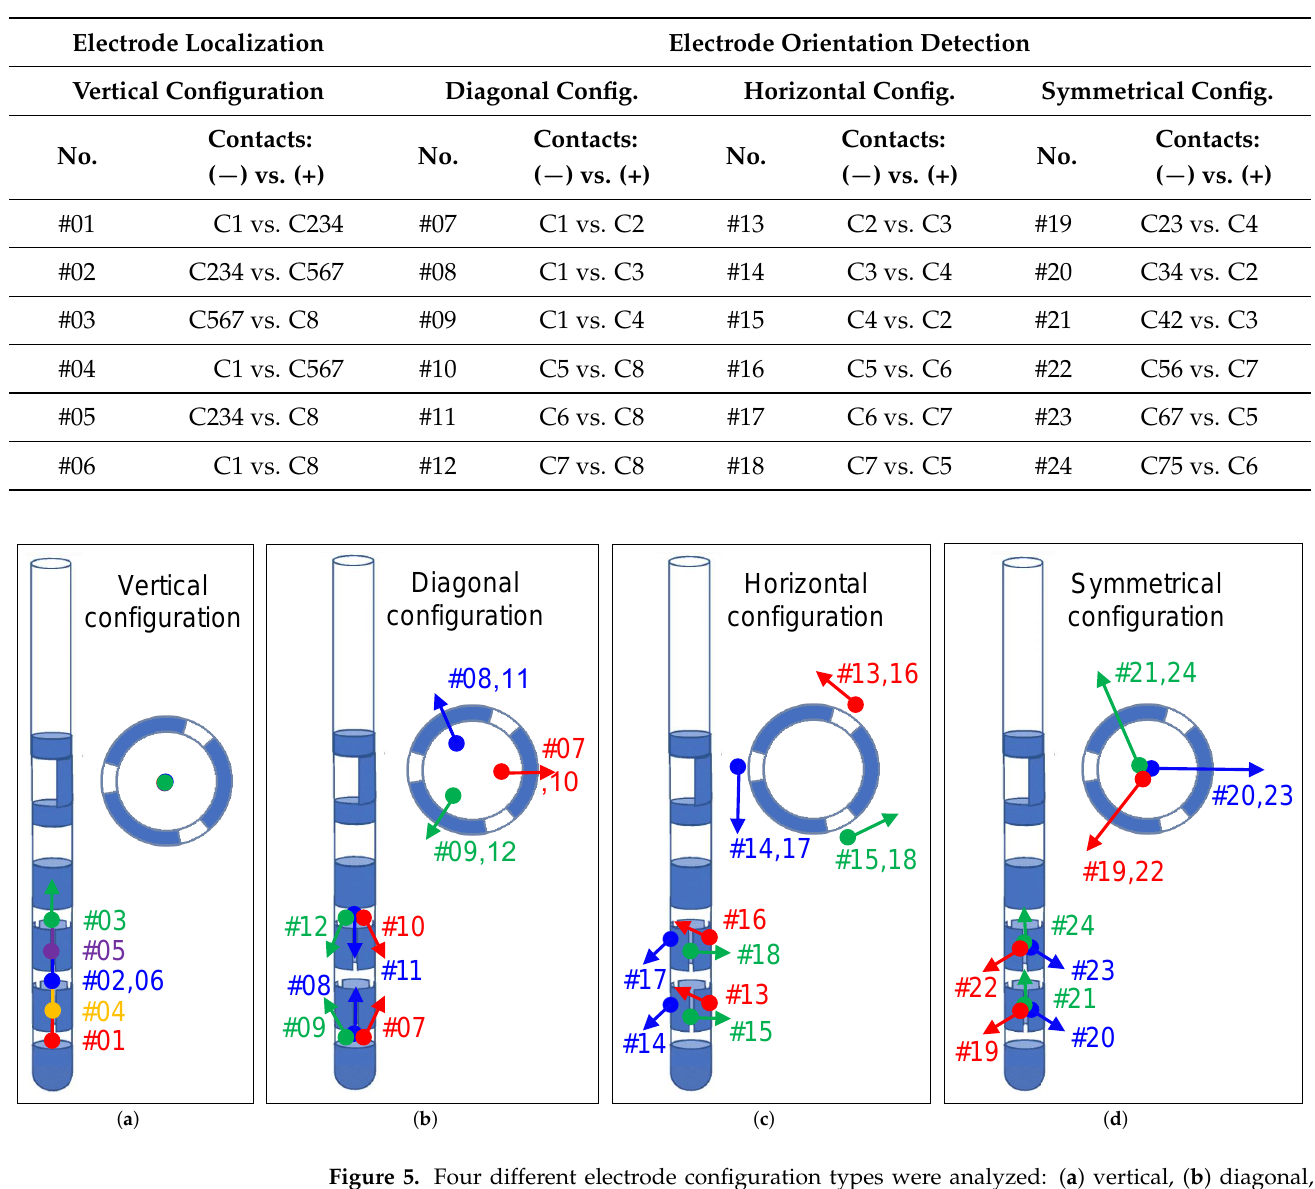
Figure 5. Four different electrode configuration types were analyzed: ( a ) vertical, ( b ) diagonal, ( c ) horizontal, and ( d ) symmetrical electrode configurations, which differ in the physical center of stimulation (thick colored dots) and the direction of current flow (colored